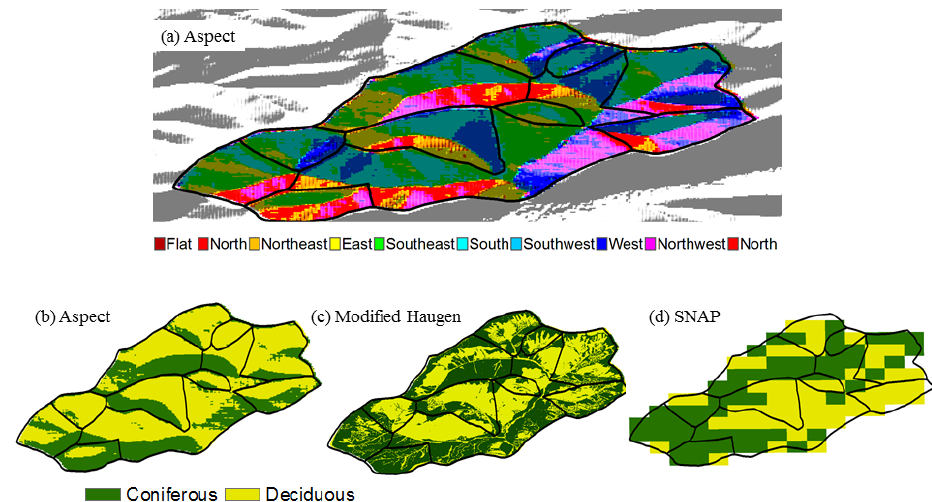
Figure 3. (a) Aspect map – derived from the DEM – of the CPCRW. Coniferous and deciduous vegetation composition at the CPCRW as derived from (b) model-based aspect or topography of the watershed, (c) an observation-based vegetation coverage map modified from Haugen et al. (1982), and (d) a large-scale-based Scenario Network for Alaska and Arctic Planning (SNAP) vegetation coverage map is shown. Note that panel (b) is prepared from the aspect map (a) and the sub-grid parameterization method discussed in Sect. 2.2.